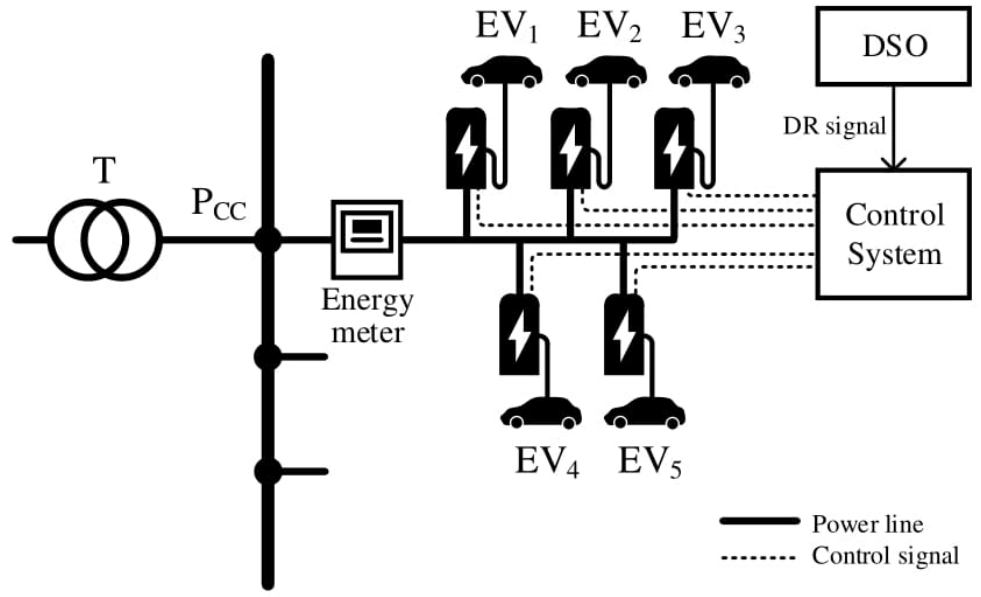
Figure 1. Architecture of the considered EV parking lot.